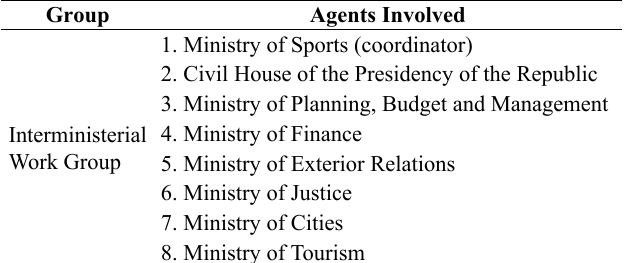
Table 3. Federal Government Organizational